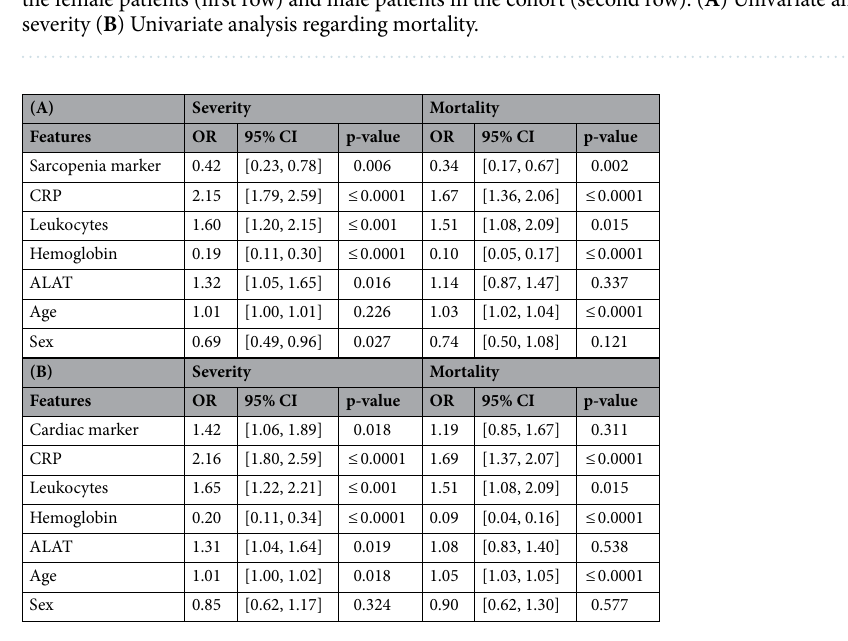
Table 3. Adjusted odds ratios including the 95% CI and the p-value for the severity and mortality endpoint for ( A ) sarcopenia marker and ( B ) cardiac marker.